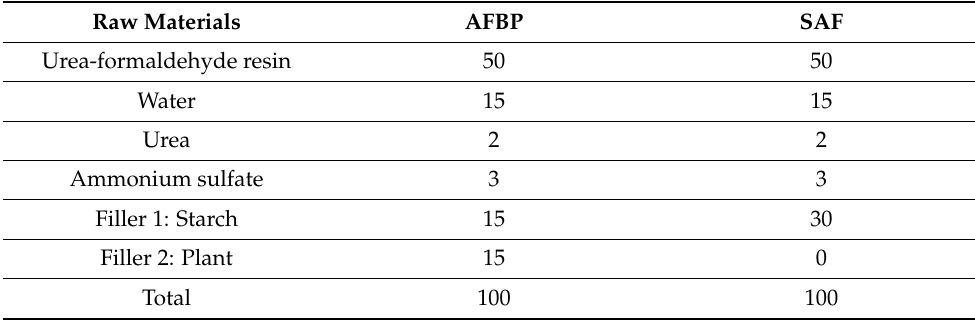
Table 1. The constituents in percentage (%) of the